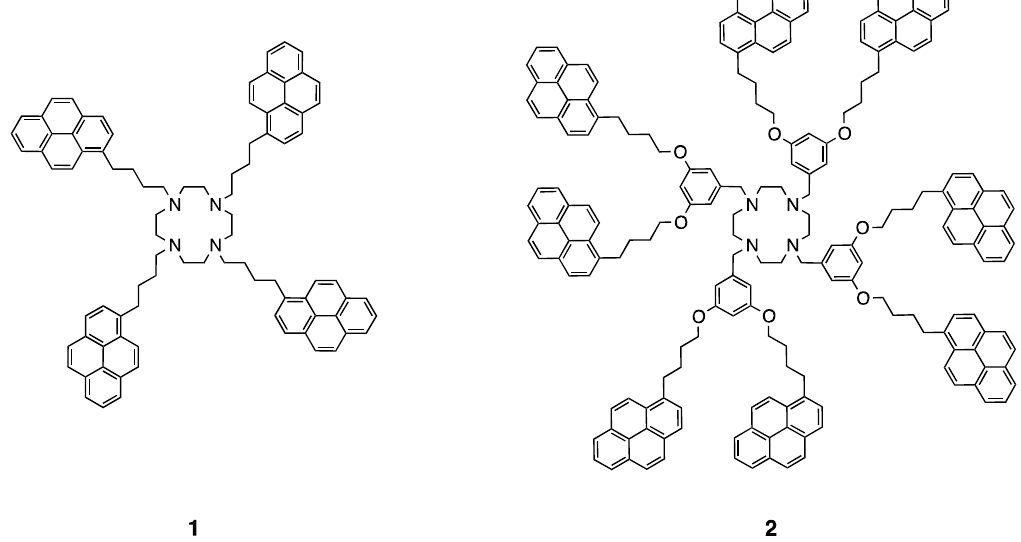
Figure 14. Structures of the cyclen-based ligands containing four and eight pyrene units [50].